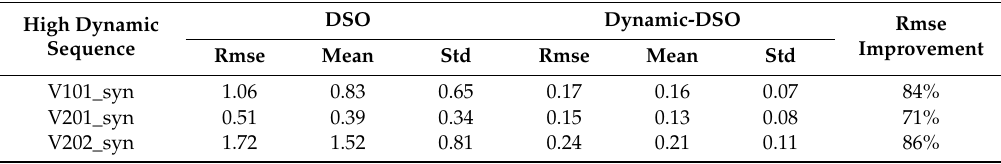
Table 2. Comparison of Absolute Pose Error (APE) for translation part in modified Euroc dataset. (Unit: m). Figure 14. Boxplot of the trajectory error between Dynamic-DSO and DSO in V101_syn, V201_syn and V202_syn.